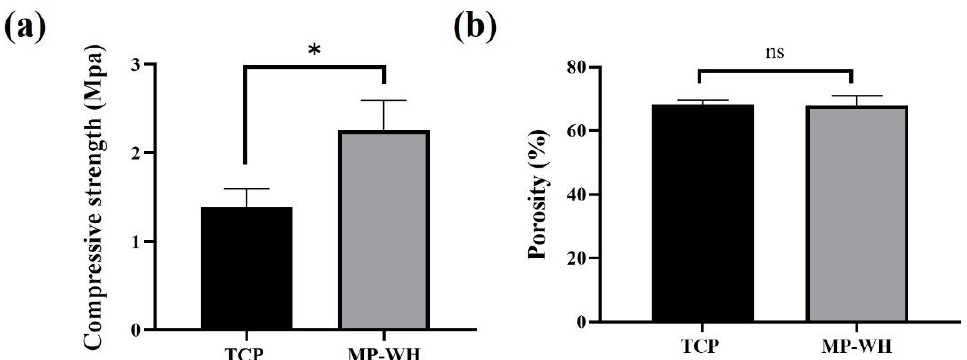
Figure 2. Compressive strength ( a ) and porosity ( b ) of tricalcium phosphate (TCP) and marine plankton-derived whitlockite (MP-WH) 3D scaffolds. Data are represented as the mean ± standard deviation (SD) for three samples. * indicates significant differences when compared with the TCP 3D scaffold ( p < 0.05). ‘ns’ indicates not significant.